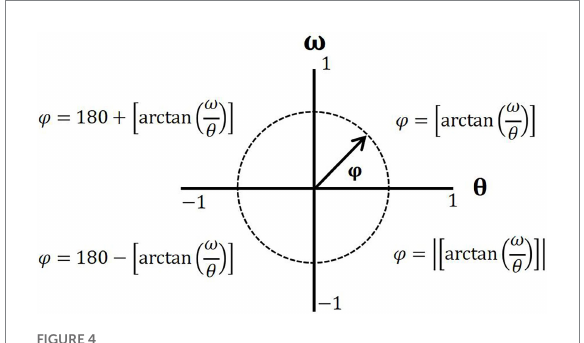
FIGURE 4 Standardization of the four-quadrant phase